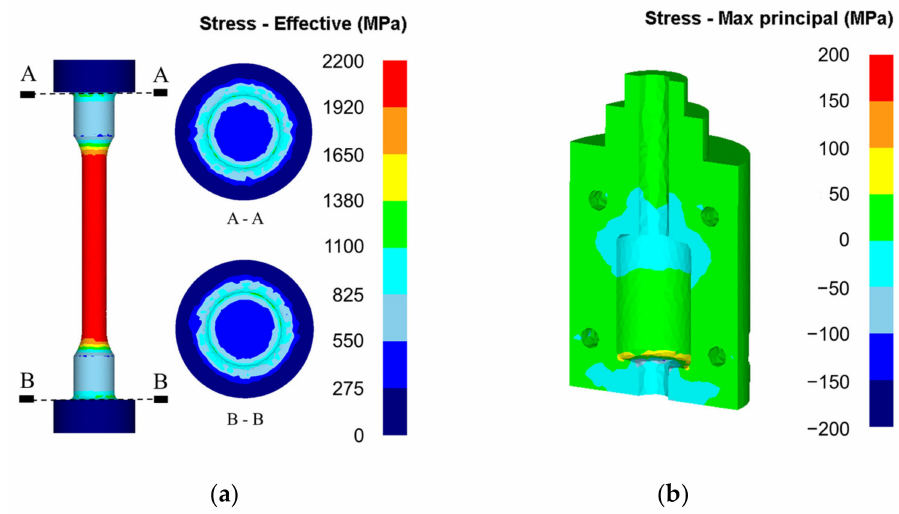
Figure 6. Result of the jig analysis of the proposed method: ( a ) effective stress of specimen and ( b ) maximum principal stress of